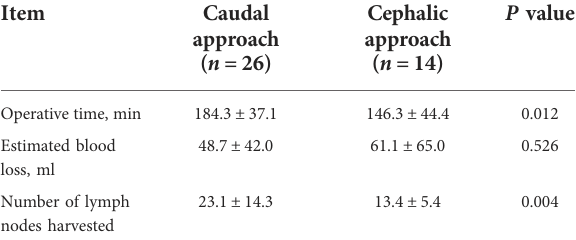
TABLE 3 Comparison of different approaches of laparoscopic transverse